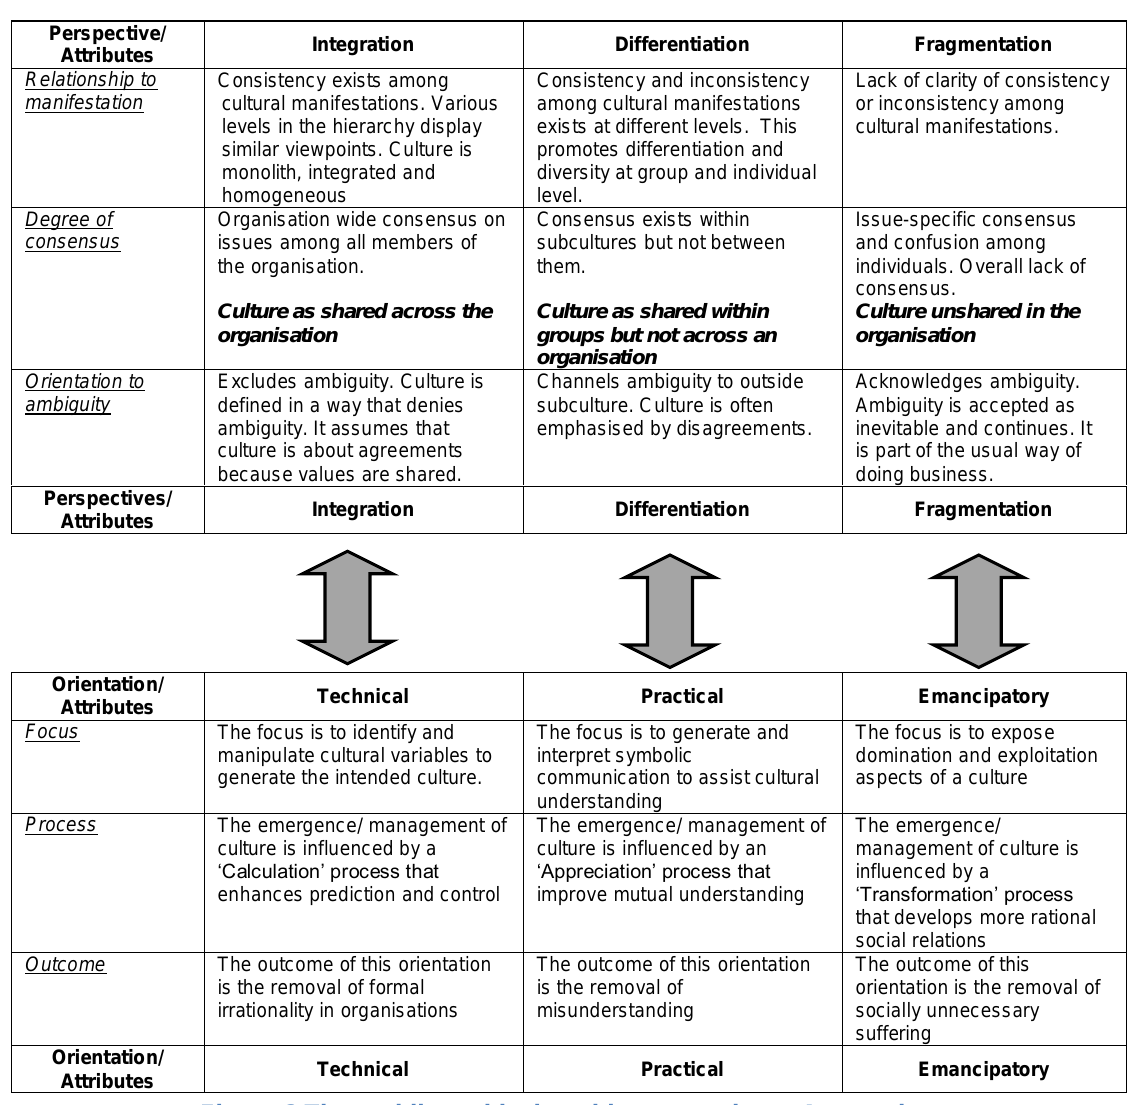
Figure 2 Three philosophical positions on culture: A